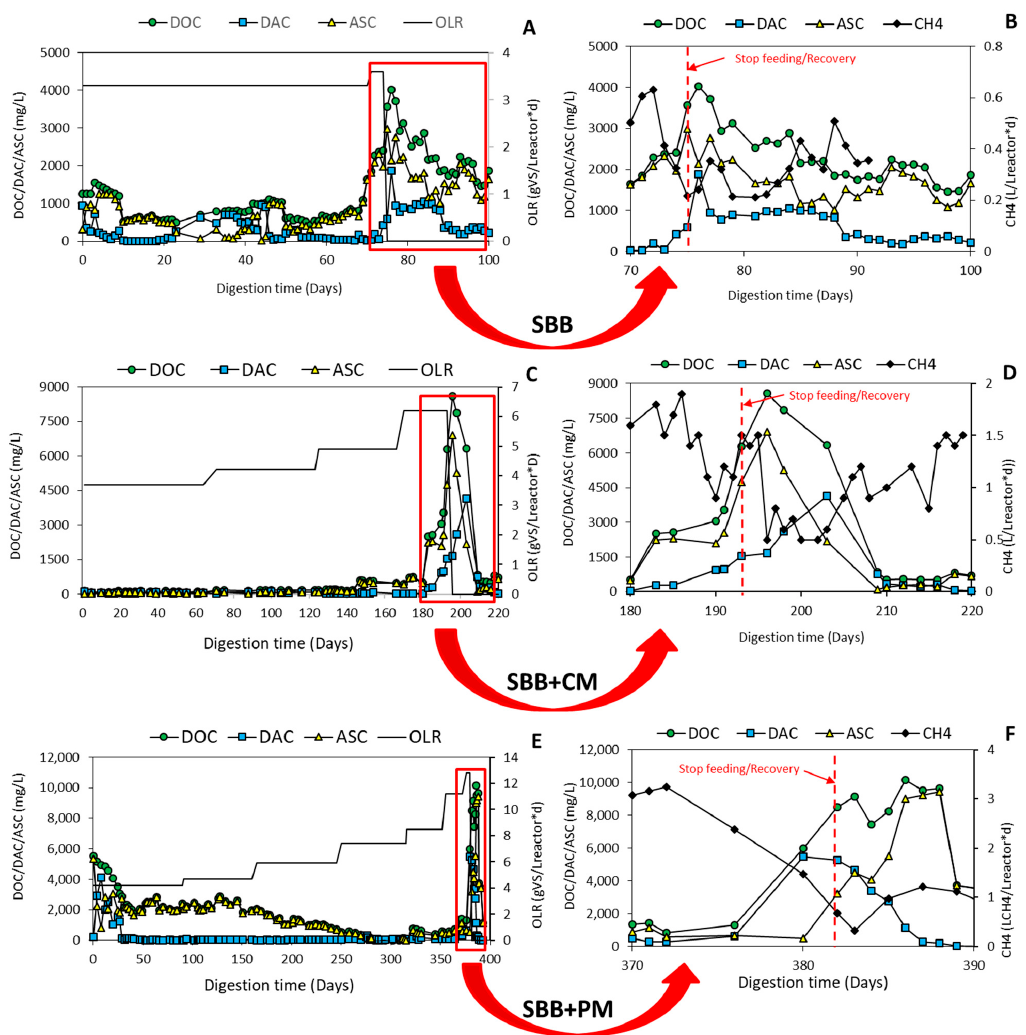
Figure 6. Evolution of the dissolved organic carbon (DOC) and indirect parameters in the three SSTR.